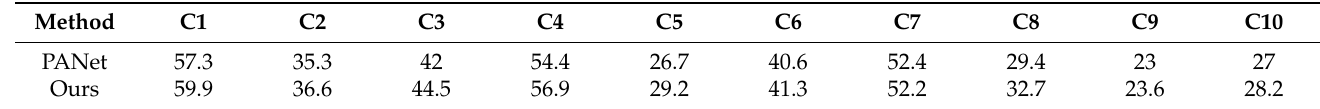
Table 3. Performance comparison of different classes on PDID-5 i